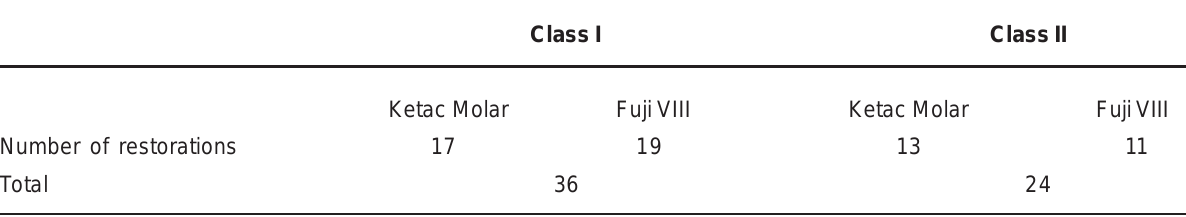
TABLE 2- Distribution of restorations according to Class type